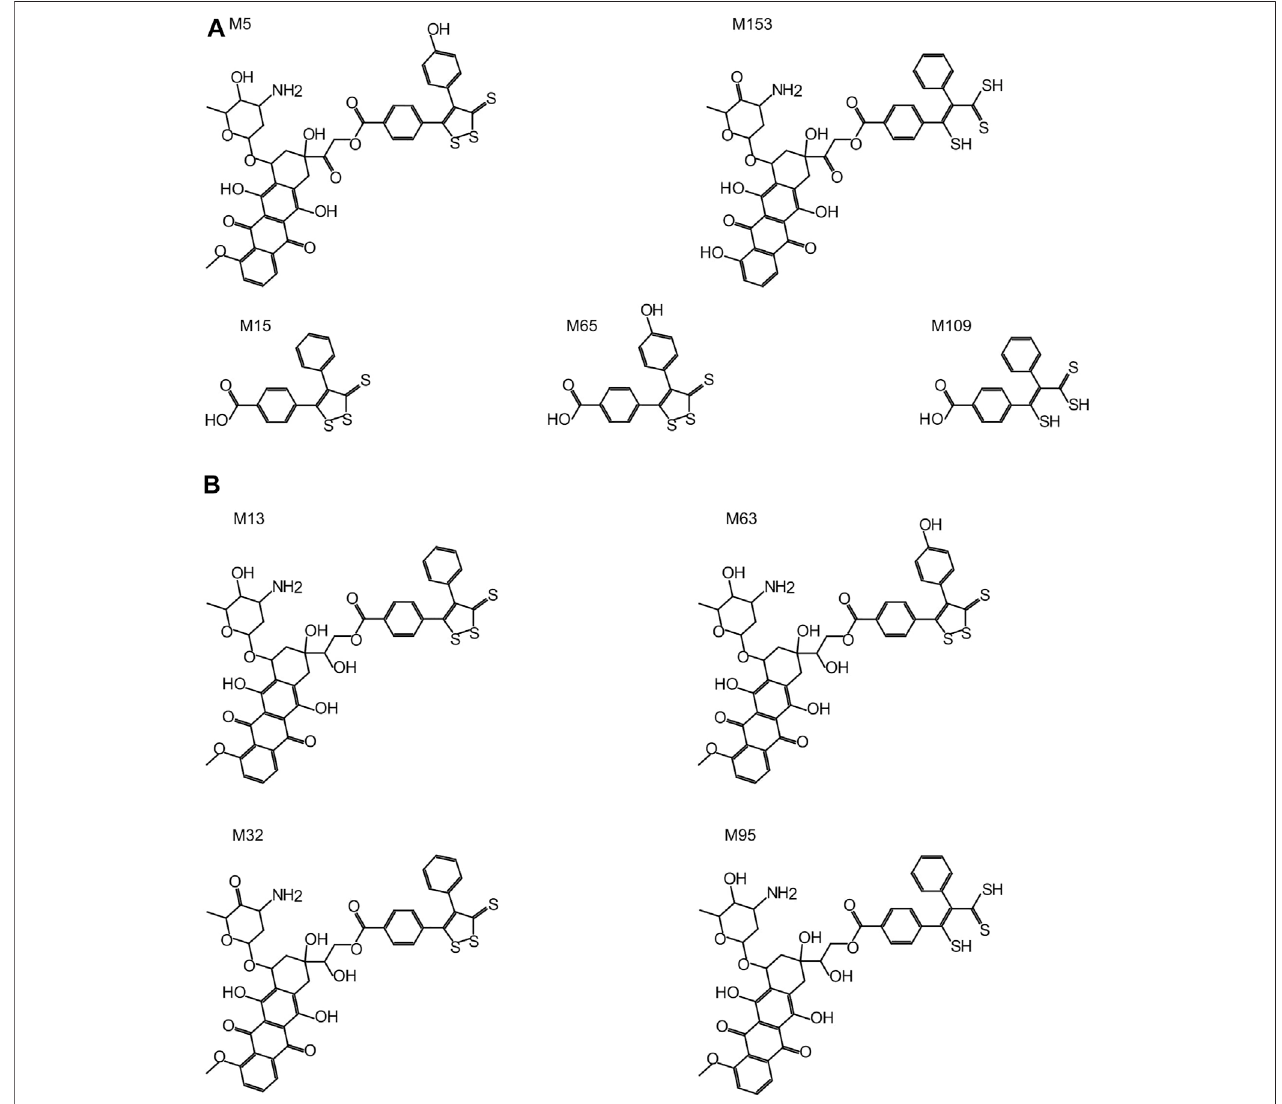
FIGURE 3 | Sdox metabolites (M). (A) Characteristic Sdox metabolites possibly acting as H 2 S donors. (B) Plausible Sdox metabolites with scaffolds identical or very similar to doxorubicinol.